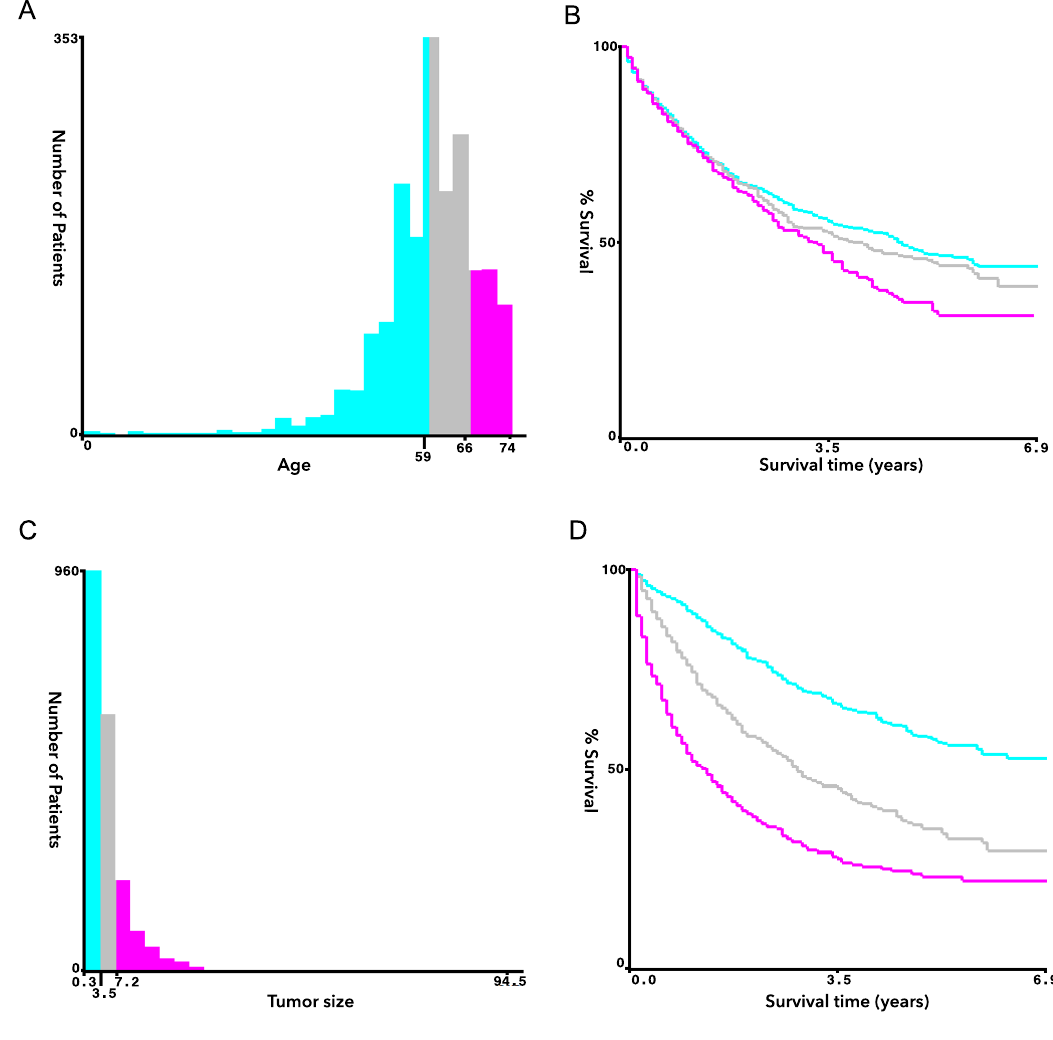
Figure 2. Age and tumor size were categorically divided based on the optimal cut-off value generated. ( A ) Survival histogram of age at diagnosis. ( B ) KaplanMeier survival analysis of age at diagnosis. ( C ) Survival histogram of tumor size. ( D ) KaplanMeier survival analysis of tumor